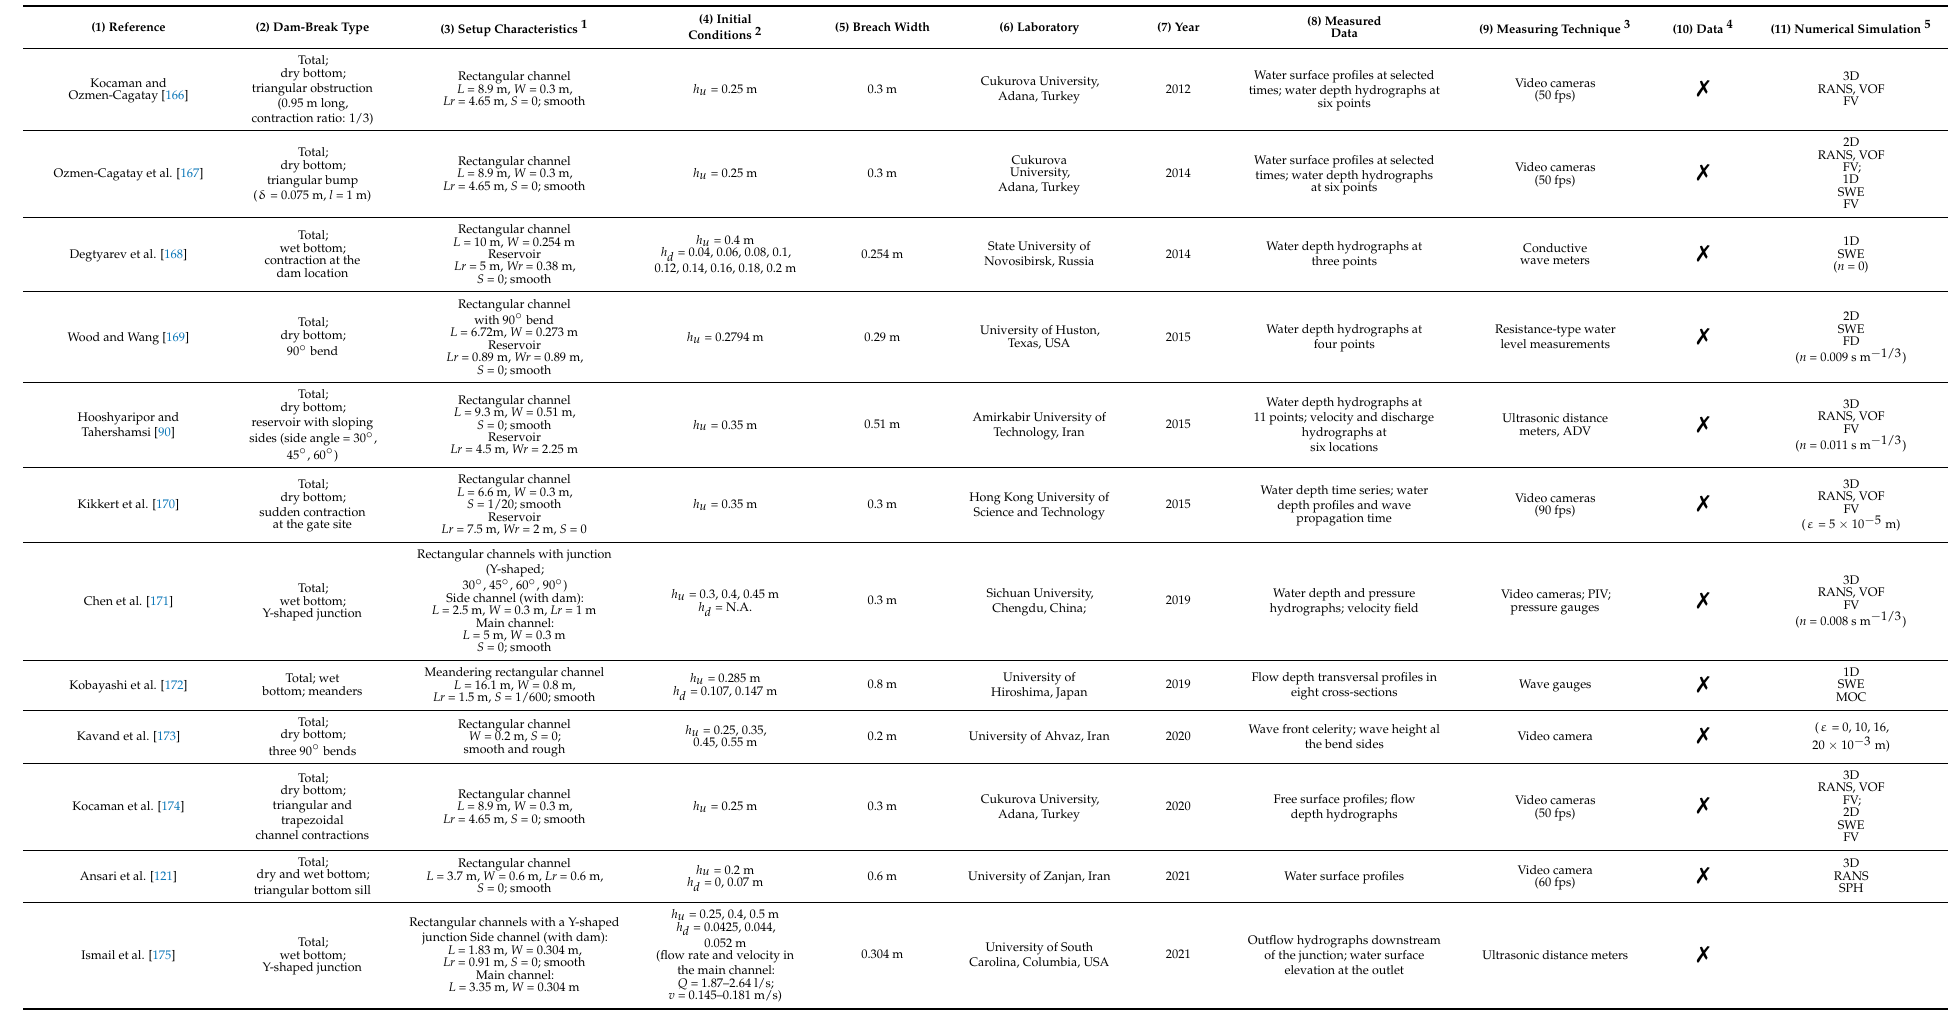
Table 1. Basic experimental investigations of fundamental dam-break wave physical characteristics.